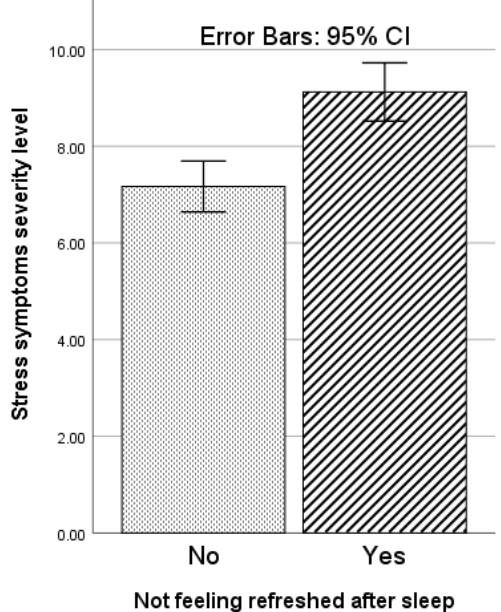
Figure 2. Variation with complaint of not feeling refreshed after sleep in stress symptoms severity